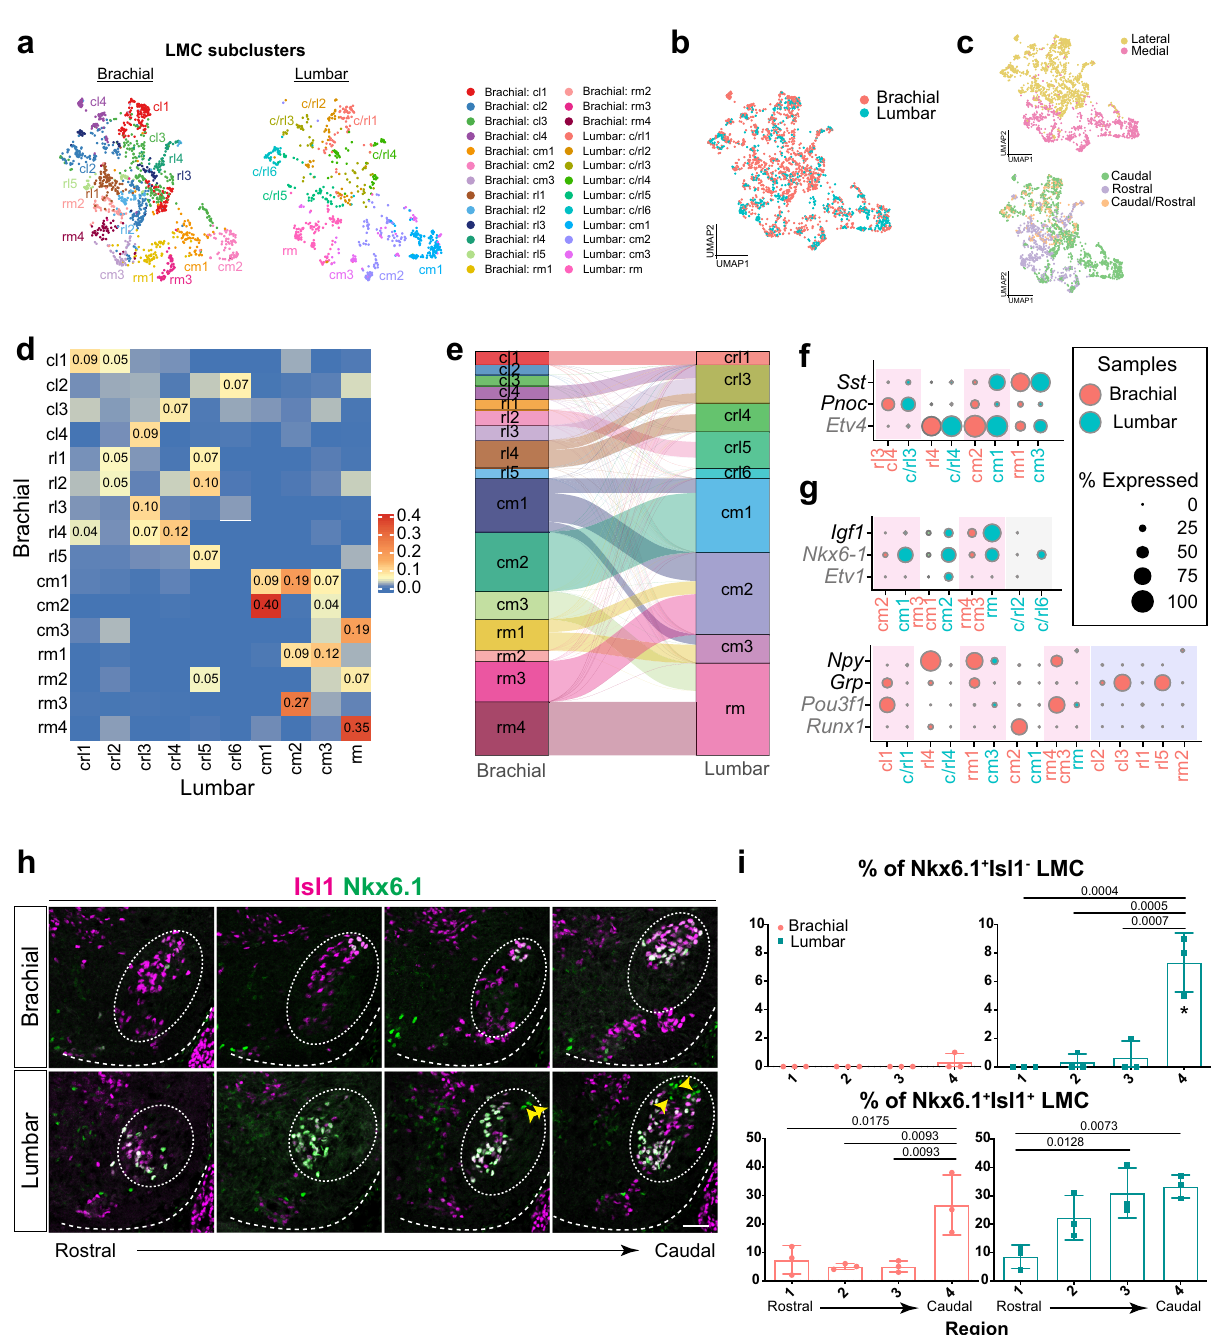
Fig. 7 | Comparison of subclusters betweenbrachial and lumbarLMCneurons. a Joint UMAP visualization of all brachial and lumbar LMC MN subclusters. b UMAP showing LMC MNs from both samples are integrated without con- founding technical artifacts. c LMC MNs with medial and lateral (upper panel), rostralandcaudal (bottom panel) identities on the jointUMAP space. d Similarity analysis between LMC subclusters from rostral and caudal segments, as re fl ected by the heatmap, was quanti fi ed by the proportion of overlapping mutual nearest neighbors. e An alluvial diagram intuitively illustrates the relatedness between brachialandlumbarLMCsubclusters.Linethicknessre fl ectsthelevelofsimilarity between subclusters, and the size of each box re fl ects total similarity. Lines with similarities <0.09 have been omitted. f , g Combined dot-plot showing marker gene expression (color-coded along Y -axis: gray for known motor pool markers; black for neuropeptides) in LMC subclusters ( X -axis) from a merged dataset. Three categories are highlighted: f selected genes expressed in both brachial and lumbar subclusters; g genes preferentially expressed in brachial (bottom panel)